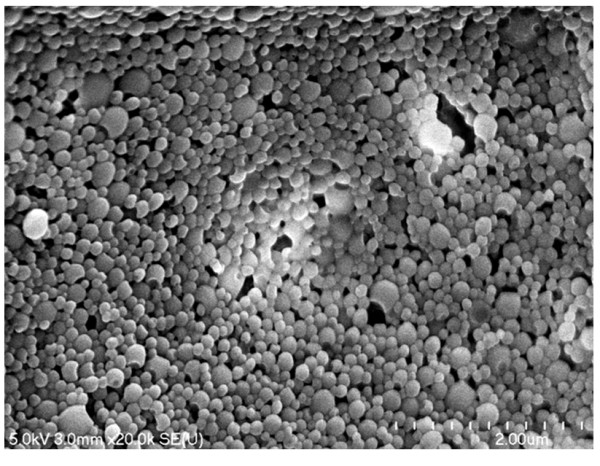
Scanning electron micrographs of Doc-loaded oily core nanocapsules after freeze drying (F6). Scale bar represents 0.2 μm.